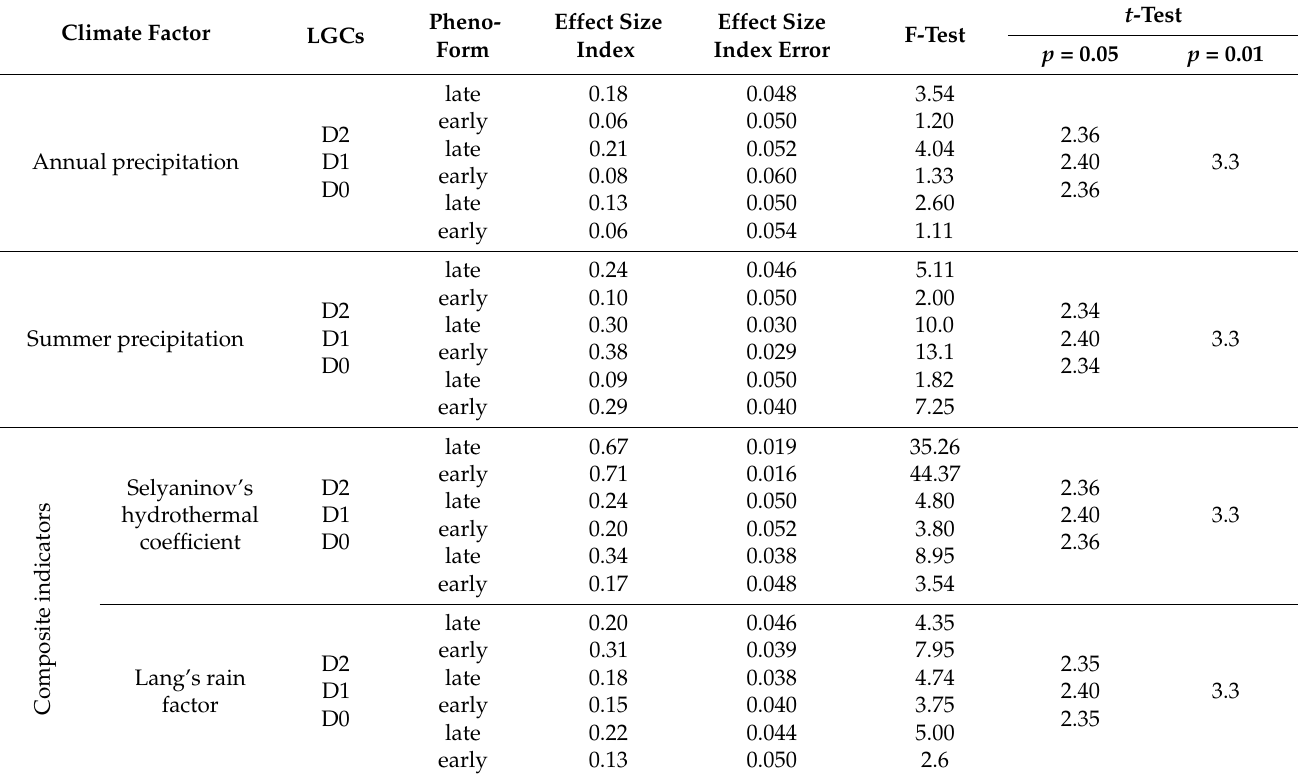
Table 3. ANOVA results for the effects of climate factors on ARW in English